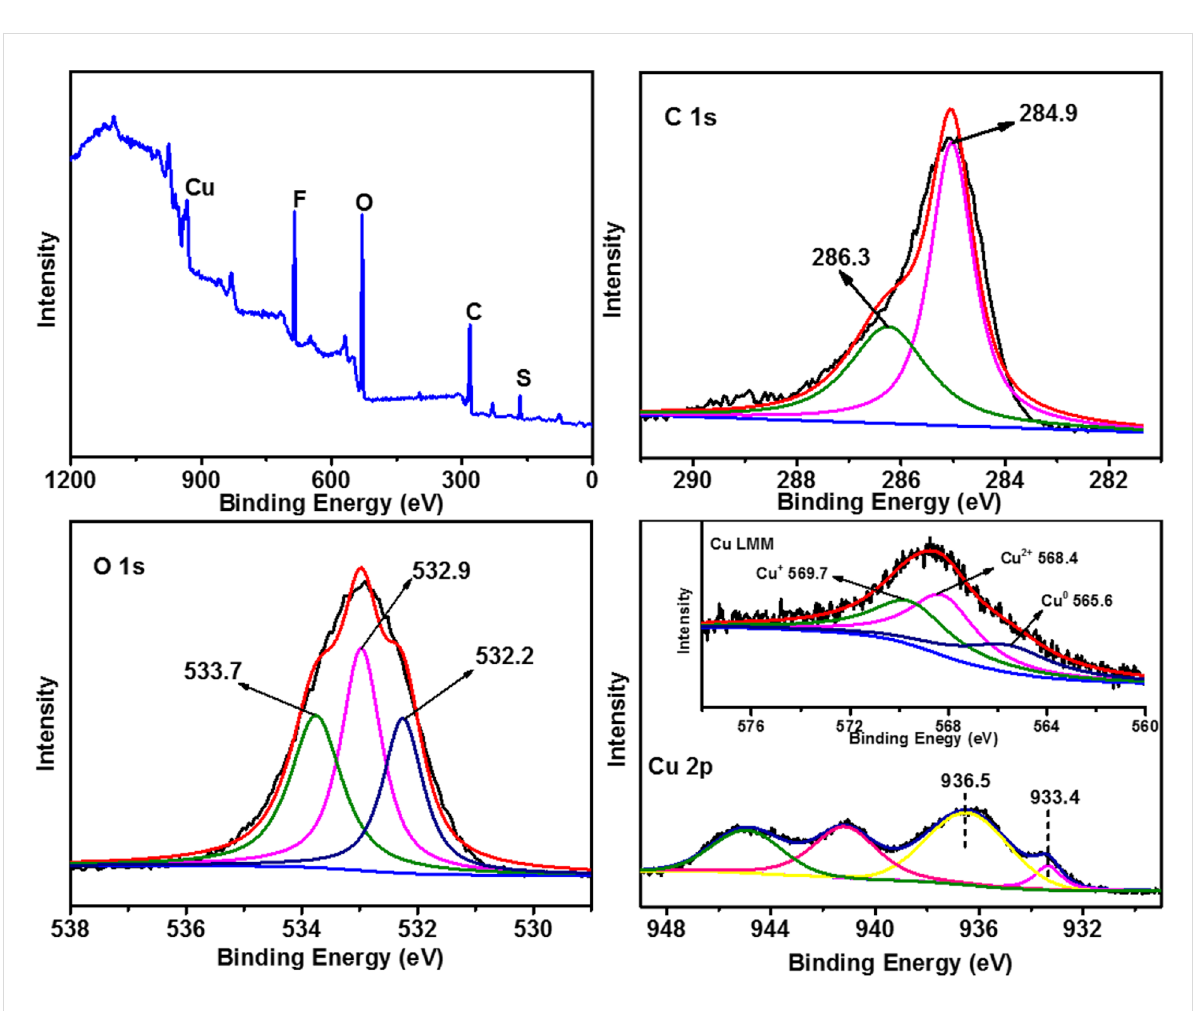
Figure 5: XPS spectra of LS-FAS-Cu in the regions of C 1s, O 1s, Cu 2p 3/2 and Cu LMM